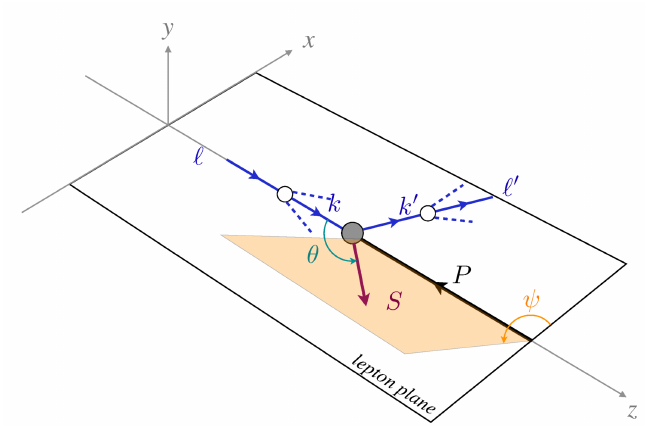
Figure 5 . Sketch of the kinematical variables describing inclusive DIS from a nucleon (with momentum P and spin S ), with the incident ( ‘ ) and scattered ( ‘ 0 ) leptons defining the lepton